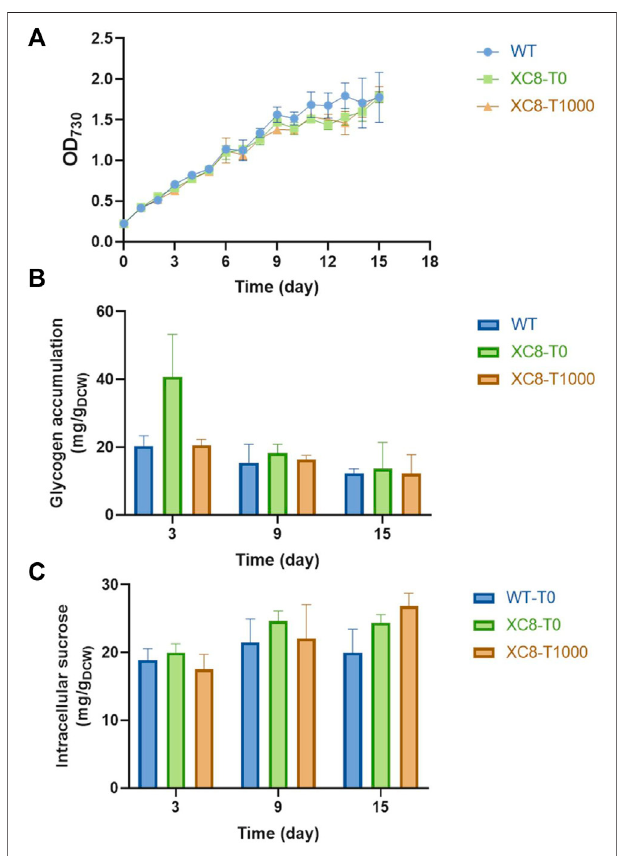
FIGURE 4 | Effects of theophylline-regulated glgP expression on salt stresstoleranceandintracellularsucrosestorageinPCC7942. (A) Growthsof PCC 7942 wildtype and XC8 mutant strains facing 150 mM salt stress imposed on Day 3 with different doses of theophylline. (B) Glycogen storage of PCC 7942 wildtype and XC8 mutant strains facing 150 mM salt stress imposed on Day 3 with different doses of theophylline. (C) Intracellular sucrose concentrations of PCC 7942 wildtype and XC8 mutant strains facing 150 mM salt stress imposed on Day 3 with different doses of theophylline.